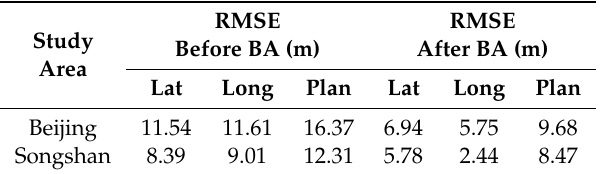
Table 1. Comparison of positioning accuracy in different areas. (BA is the abbreviation of control point free block adjustment, RMSE is the root mean square error and STD represents the standard